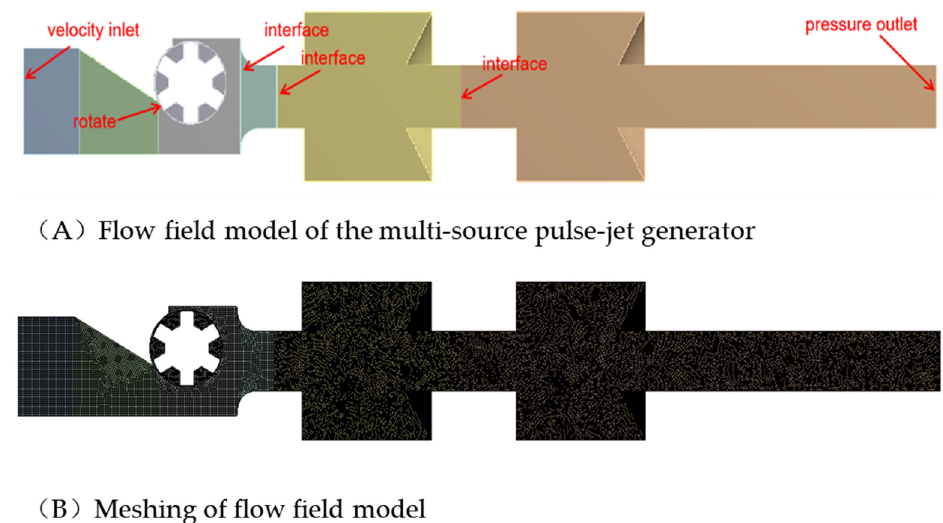
− source pulse − jet generator.